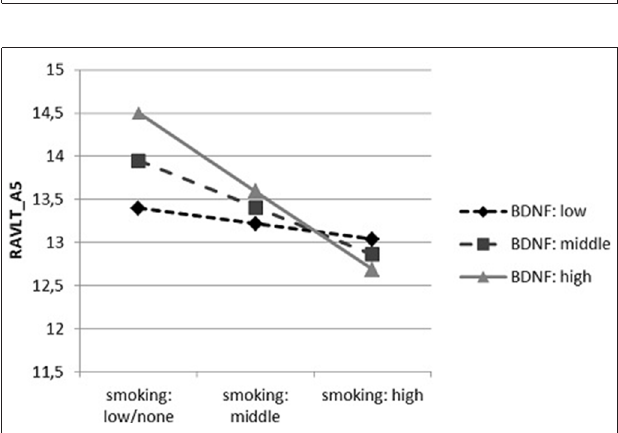
FIGURE 1 | The dependence of the results of Rey Auditory-Verbal Learning Test (RAVLT)_A2 on the age, moderated by precursor BDNF (proBNDF) concentration.